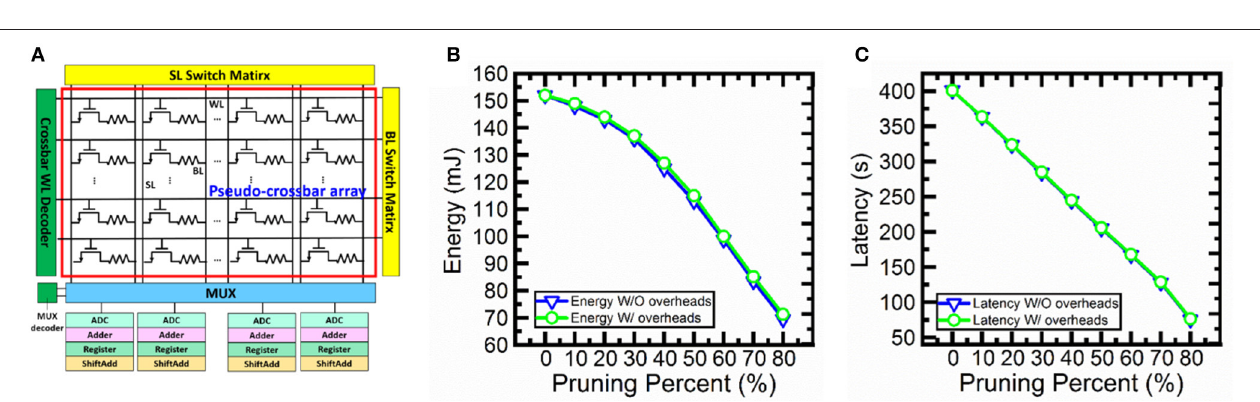
FIGURE 11 | (A) Analog synaptic core uses a single cell with multi-level conductance states to represent one synaptic weight. One transistor is added to each cell in order to avoid sneak path problem. The crossbar wordline (WL) decoder can activate all WLs, bitline (BL) read out the weighted sum results, and source line (SL) can be used to perform weight update. Multiplexer (MUX) is used to share the neuron circuitry. The neuron circuit contains analog-to-digital converters (ADCs), adders, registers and shift adders, which are used to perform weighted sum. (B) The energy and (C) latency without and with overhead estimation for soft-pruning from 10 to 80% with a step of 10% using SNN + NeuroSim. Without overheads (W/O overheads) results mean that flagging mechanism is implemented in software. With overheads (W/ overheads) results mean that flagging mechanism is implemented in